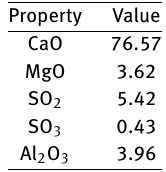
Table 3: Chemical composition of lime (%)